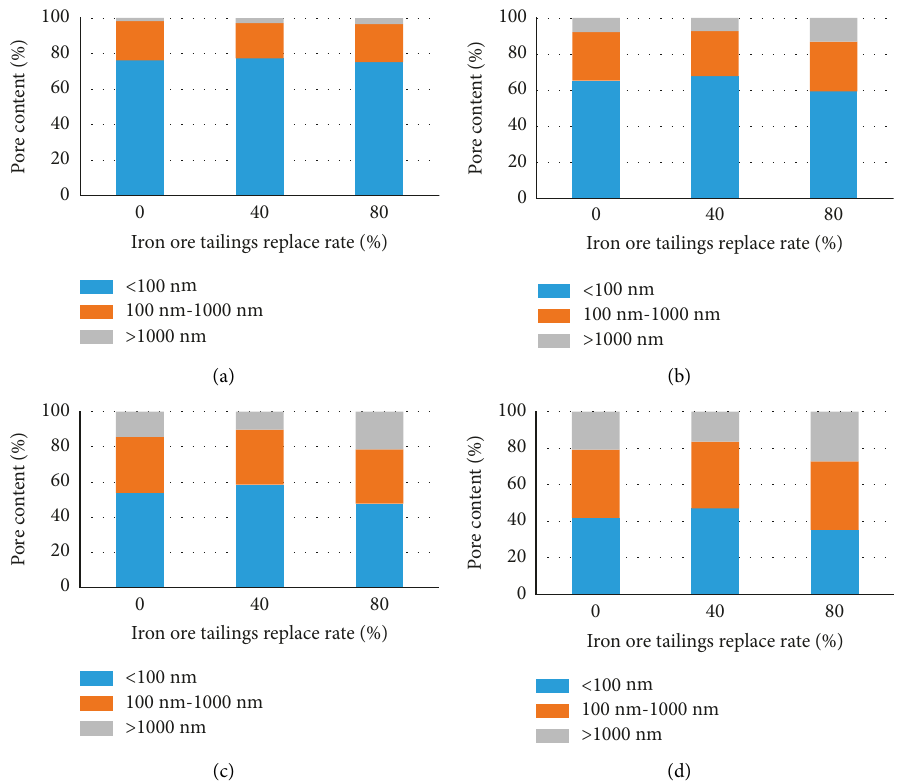
Figure 6: Pore size distribution of C30 iron tailings concrete after different freezing-thawing cycles. (a) 0 freeze-thaw cycles, (b) 40 freeze- thaw cycles, (c) 80 freeze-thaw cycles, and (d) 120 freeze-thaw